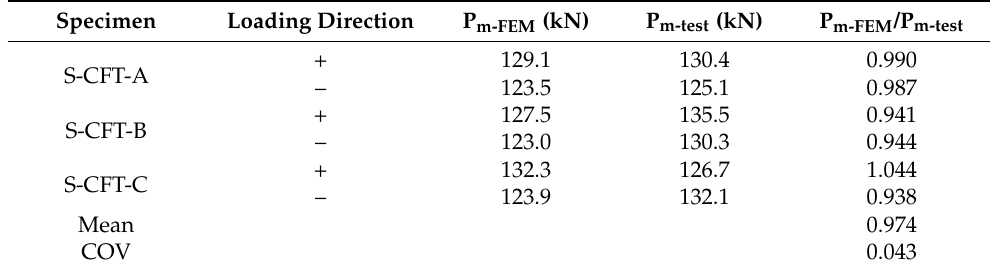
Table 7. Comparison of the peak loads between test and FEA